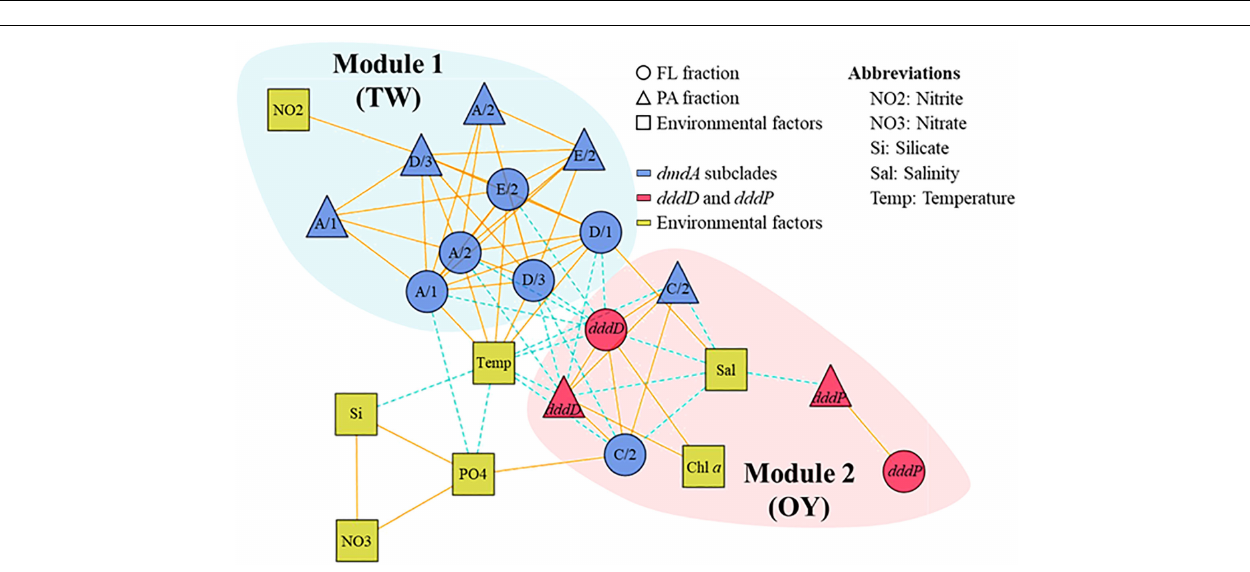
FIGURE 7 | Nonmetric multidimensional scaling (NMDS) plot revealed temporal succession of dimethylsulfoniopropionate (DMSP) degradation gene distributions in the Sanriku Coast. After fitting with environmental parameters ( P < 0.05), gene distributions in both free-living (FL) (a) and particle-associated (PA) (b) fractions were influenced significantly by temperature, salinity, and nitrite concentrations, while silicate, phosphate, and nitrate concentrations only influenced the FL fractions.